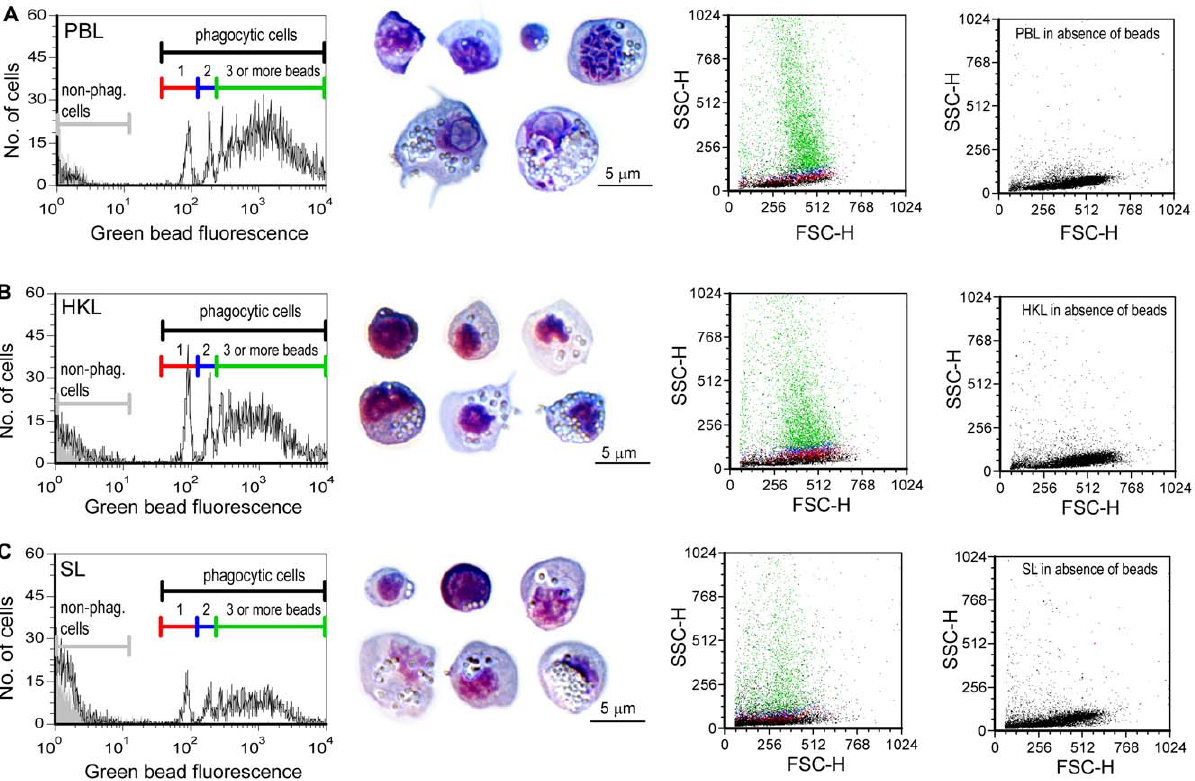
Figure 5. The phagocytic capacity of isolated leucocytes is high. FL1 (green bead fluorescence) histograms (left) showing phagocytic capacity of PBL (A), HKL (B) and SL (C) incubated with fluorescent beads (1 m m) for 4 h. Increased peak fluorescence indicates an increased number of ingested beads. Picture insets show cells stained with Colorrapid from PBL, HKL and SL samples that have ingested various numbers of beads. The left dot plots show cells in the red (cells with 1 bead) blue (cells with two beads) and green (cells with 3 or more beads) and black (non-phagocytic cells) regions; cells with a higher number of ingested beads have a higher granularity (SSC-value). The dot plots to the right show the light scatter properties of the cells incubated without beads at the instrument settings used for the phagocytosis assay.